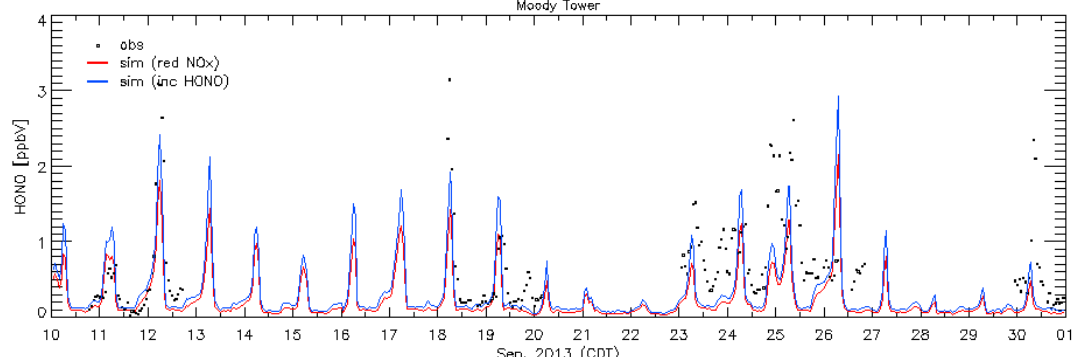
Figure 6. HONO mixing ratios measured at the Moody Tower site and modeled with and the regular HONO emissions (N) for which the HONO / NO x emission ratio of 0.008 was used, and the increased HONO case (NH) for which the HONO / NO x emission ratio of 0.016 was used.